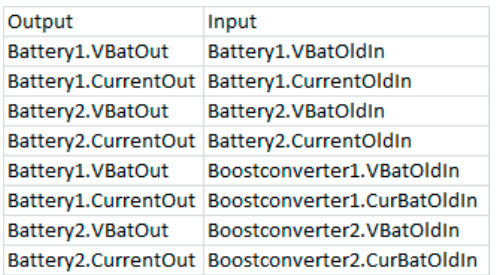
Figure 6. Example of a backwards connector table used to connect component instances port wise.